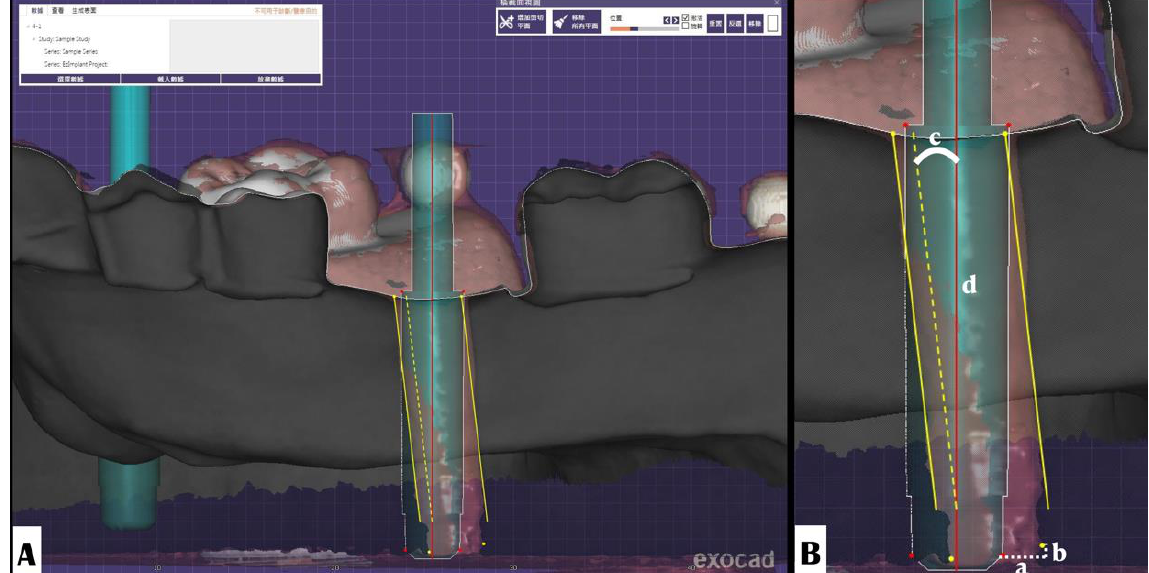
Figure 6. ( A ) Superimposition of the virtual plan and postsurgical position; measurement of points and angle deviations are based on the reference line. ( B ) a: horizontal deviation measurement between red dots (reference point) and yellow dots (postsurgical point); b: vertical deviation measurement; c: angulation deviation measurement; d: reference line (red line): the central axis of ideal implant position.